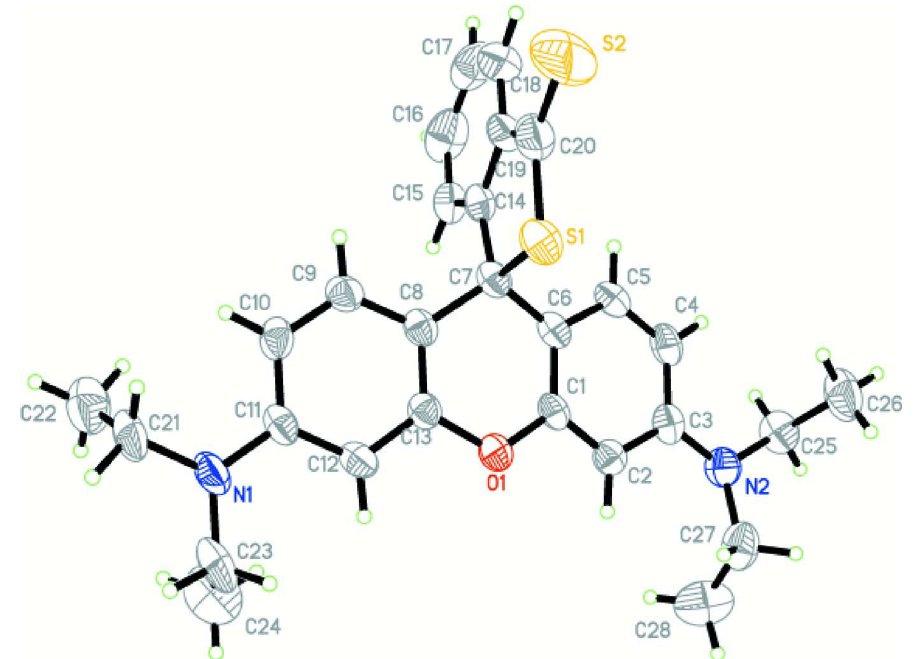
A view of the molecular structure of the title compound with the atom-labelling scheme, showing 50% probability displacement